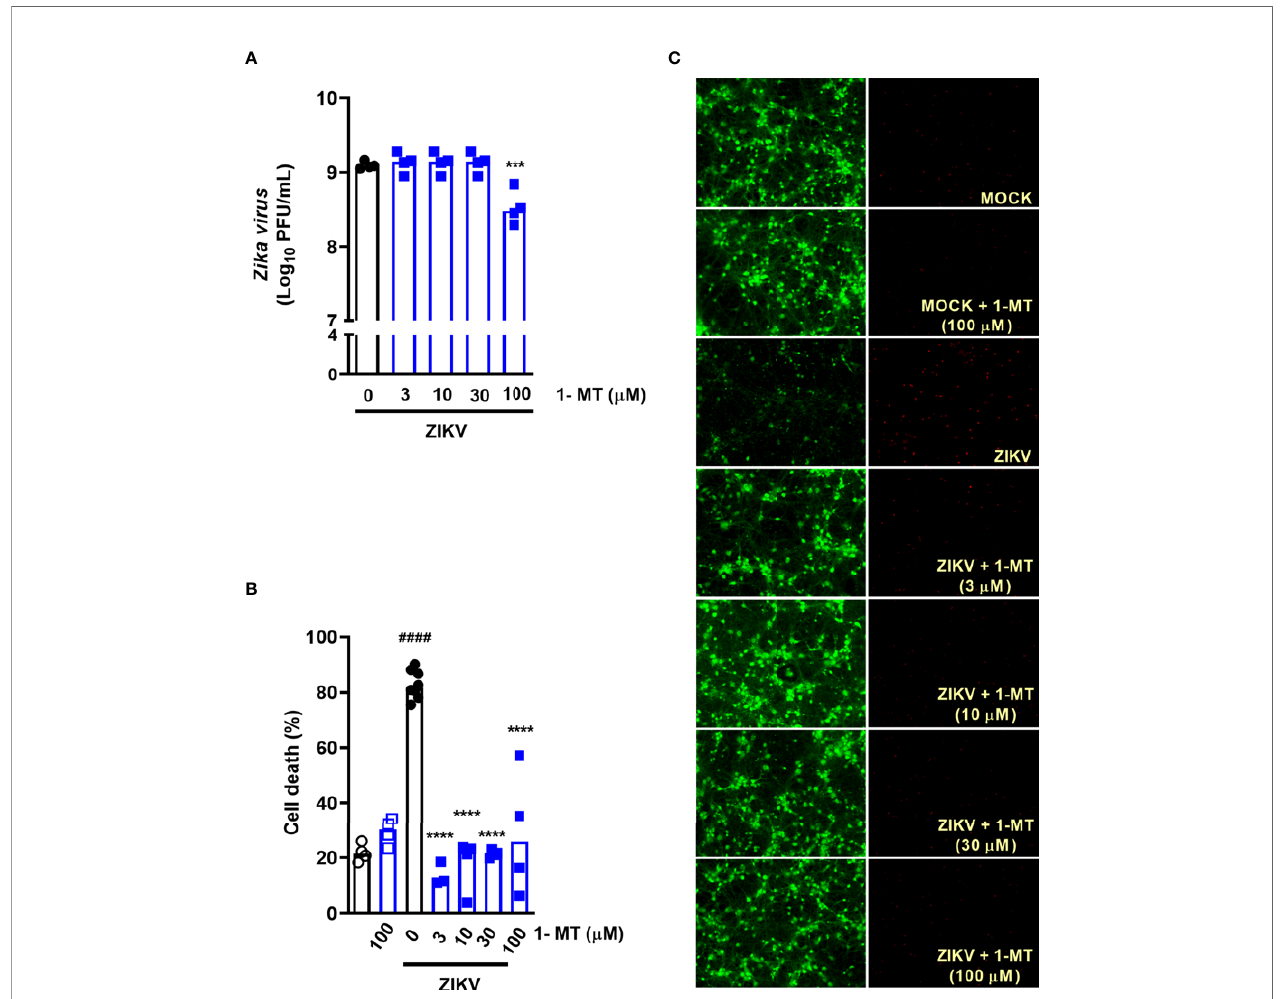
FIGURE 2 | IDO-1 inhibition in primary undifferentiated neurons infected by ZIKV. Primary culture of cortical-striatal neurons on D5. Neuronal culture from C57BL/6 mice were infected with ZIKV (MOI 0.1) and treated with 1-MT inhibitor at concentrations of 3; 10; 30 and 100 µM. After 48 hours, (A) the supernatant was collected to assess viral load, (B) cell death was assessed using the LIVE/DEAD Cell Viability Assay. (C) Representative images of infected and uninfected neurons stained with calcein AM (green indicates live cells) and ethidium homodimer (red indicates dead cells). All results are expressed as median and are representative of at least two independent experiments. Statistically signi fi cant differences were assessed by One-way ANOVA plus Holm-Sidak ’ s or Tukey ’ s comparisons test. (####) for P < 0,0001 compared to the MOCK group; (***) for P < 0,001 and (****) for P < 0,0001 compared to the ZIKV